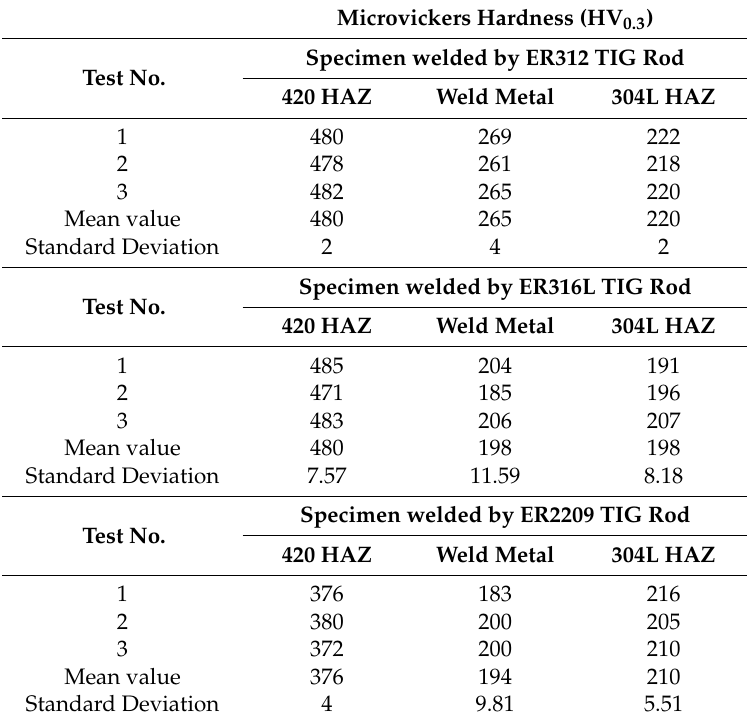
Table 4. Micro-hardness values of